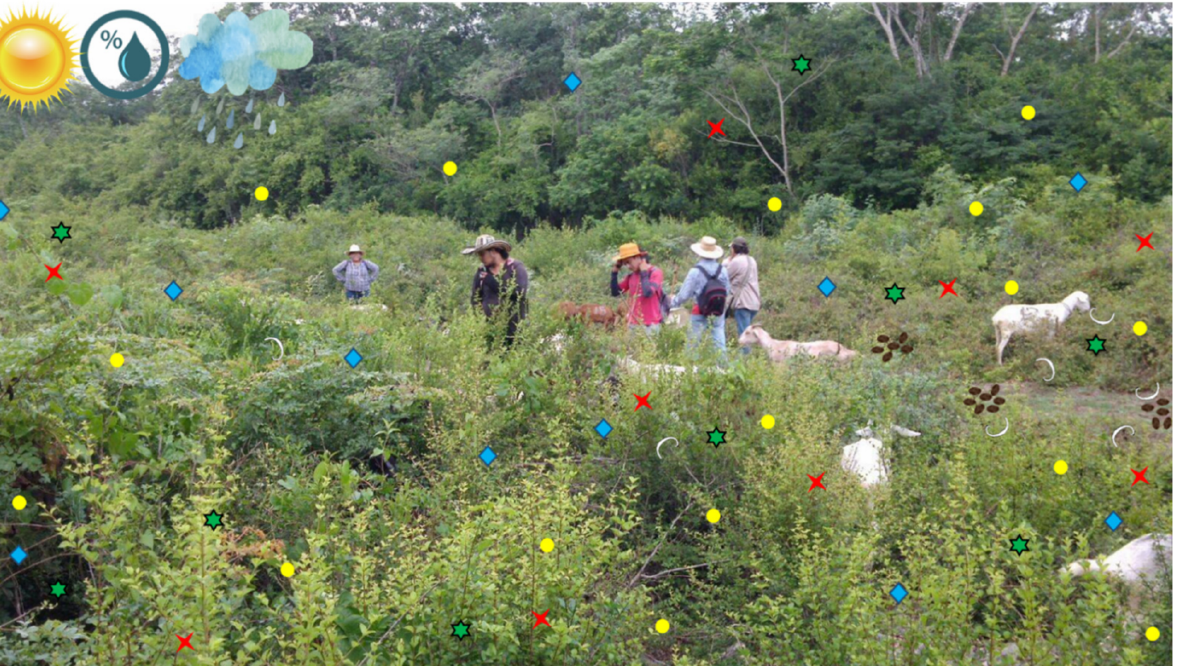
Figure 1. A brief depiction of the natural scenario in the low deciduous forest. Within this heterogenous context, temper- ature/solar radiation ( ), humidity ( ), and rainfall ( ) are variable throughout the year. Approxi- mately, 260 plant species have been considered as valuable resources for ruminant feeding. There are 80 plants verified as consumed by sheep and goats through direct observation. Each one containing different levels and concentrations of nu- trients ( ), plant secondary compounds like terpenes ( ), alkaloids ( ), and phenolic compounds ( ). In addition, there are other components making part of the grazing paddock such as gastrointestinal nematodes’ eggs ( ), and infective larvae ( ). Other herbivores such as domestic cattle, white-tailed deer (Odocoileus virginianus yucatanensis), reptiles, birds, and insects are part of the landscape. Also, farmer management and human (non-farmer) impacts are important factors which must be studied and understood in order to improve its utilization and design more sustainable production systems in this “ever-changing” environment.